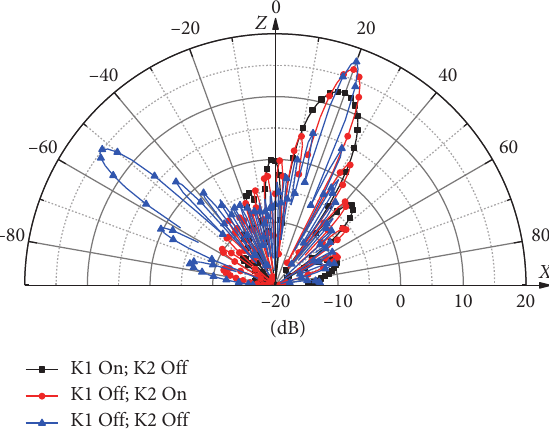
Figure 14: Simulated radiation pattern of the uniform FRAA with the beam steering angles of θ